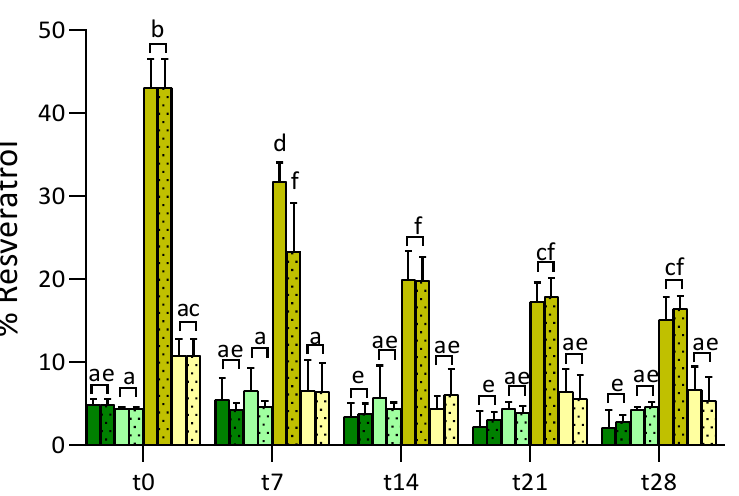
Figure 4. Percentage of resveratrol dissolved in RSV-juice (dark green), RSV-CA (light green), γ-CD·RSV-juices (yellowish green) and γ-CD·RSV-CA (light yellow) along 28 storage days at room temperature (rt) (without pattern) and 4 ◦ C (dotted pattern). Different letters in the same column indicate significant differences ( p <